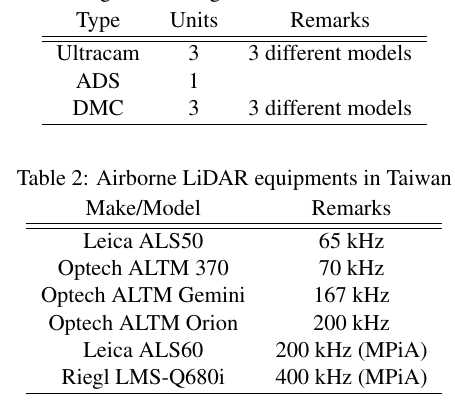
Table 1: Large format digital aerial cameras in Taiwan